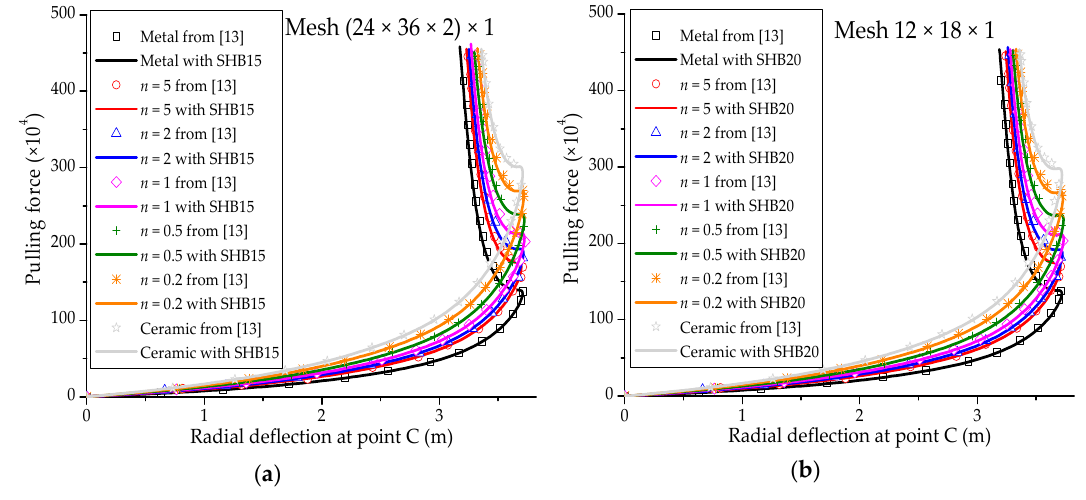
Figure 17. Radial displacement at point C under concentrated force for the open-ended cylinder. ( a ) prismatic SHB15 element; ( b ) hexahedral SHB20 element.